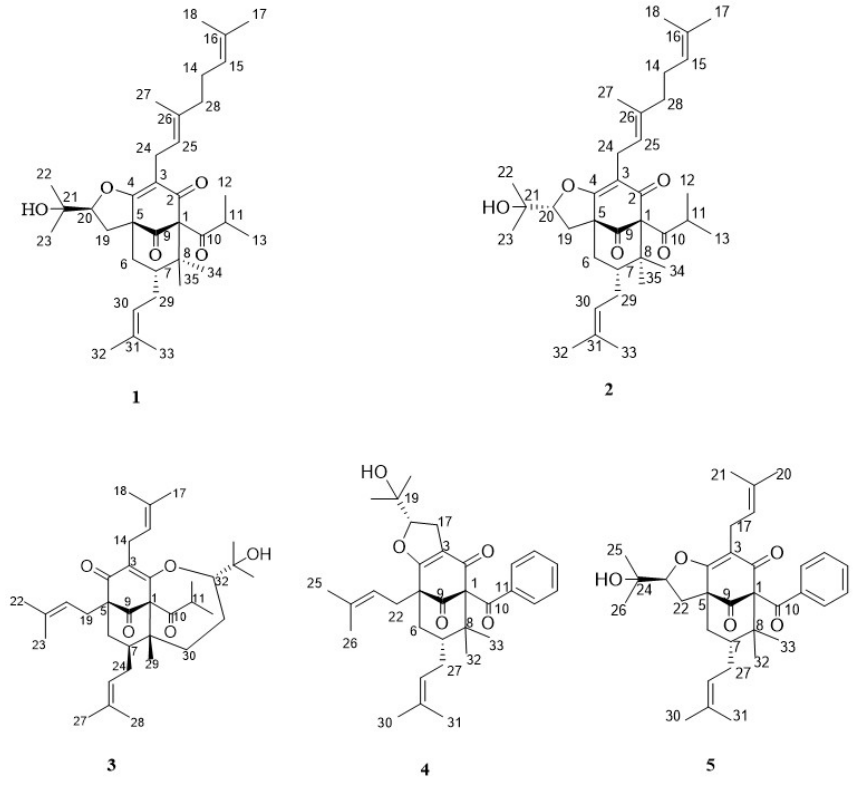
Figure 1. Structure of compounds 1 – 5